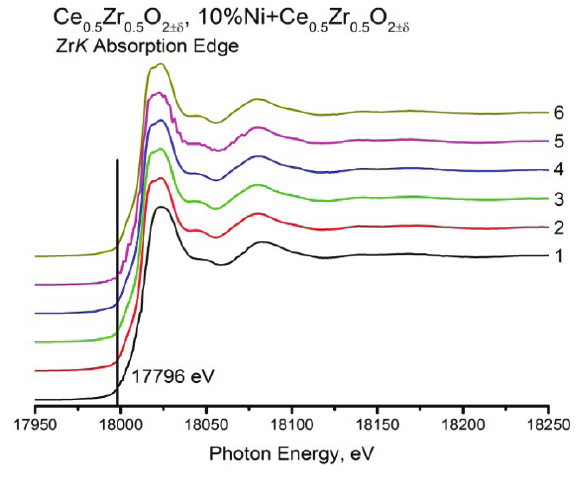
Figure 6: X-ray absorption spectra near Zr K absorption edge: